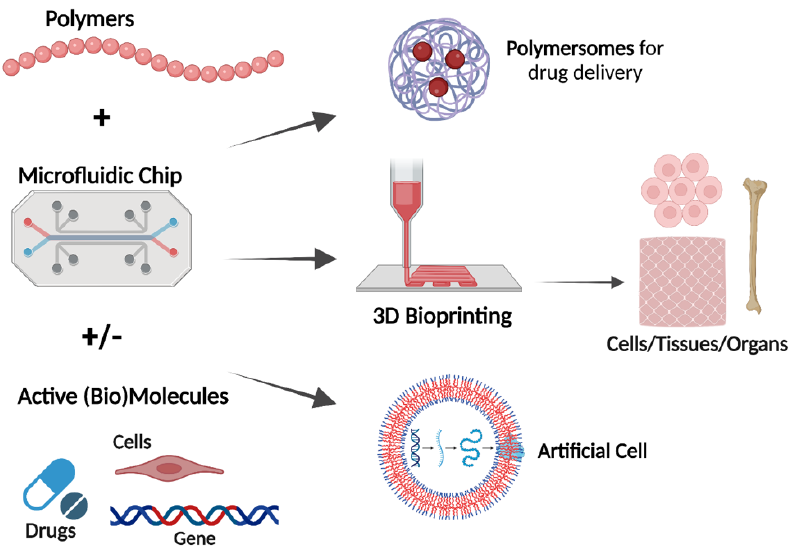
Figure 1. Utilizing of microfluidic chips and polymers for various applications (Created with Biorender.com, accessed on 12 October 2022).